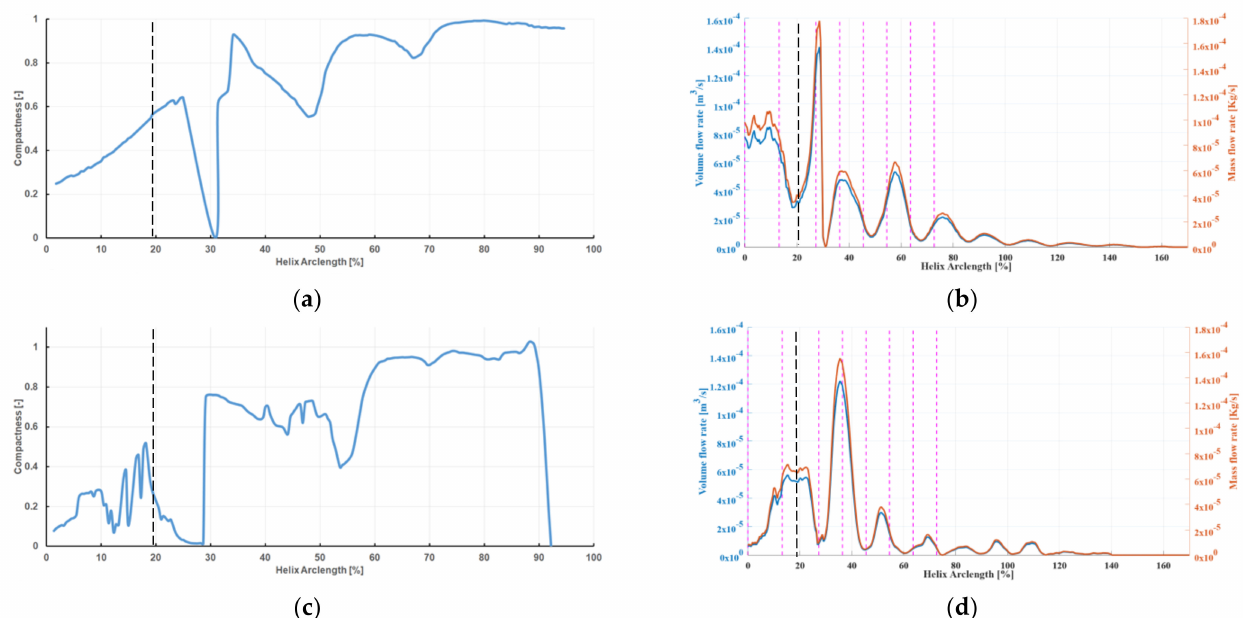
Figure 15. Newcastle. Tip vortex longitudinal evolution analysis: ( a ) C2: shape; ( b ) C2: flow rate; ( c ) C6: shape; ( d ) C6: flow